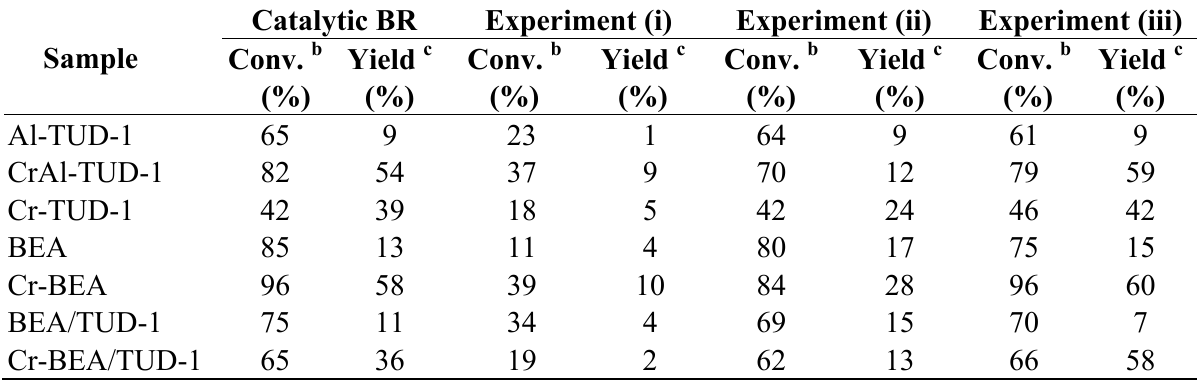
Table 2. Catalytic results for the reaction of glucose in the presence of the prepared materials, using [bmim]Cl as solvent, at 120 °C (Catalytic BR), and related catalytic tests for investigating catalyst stability (experiments (i), (ii) and (iii)) a